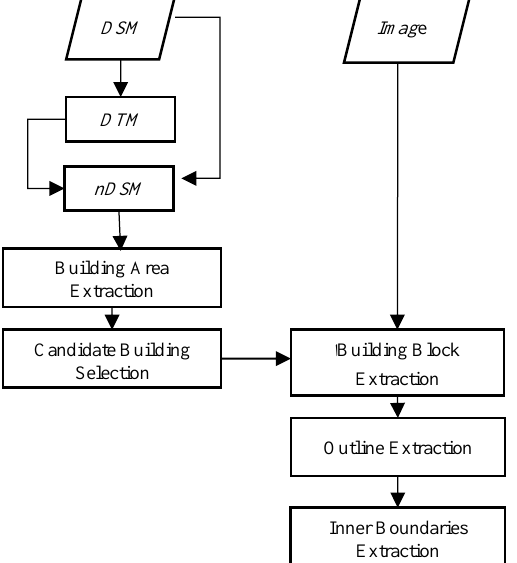
Figure 1. Workflow for building footprints using optical imagery and LiDAR